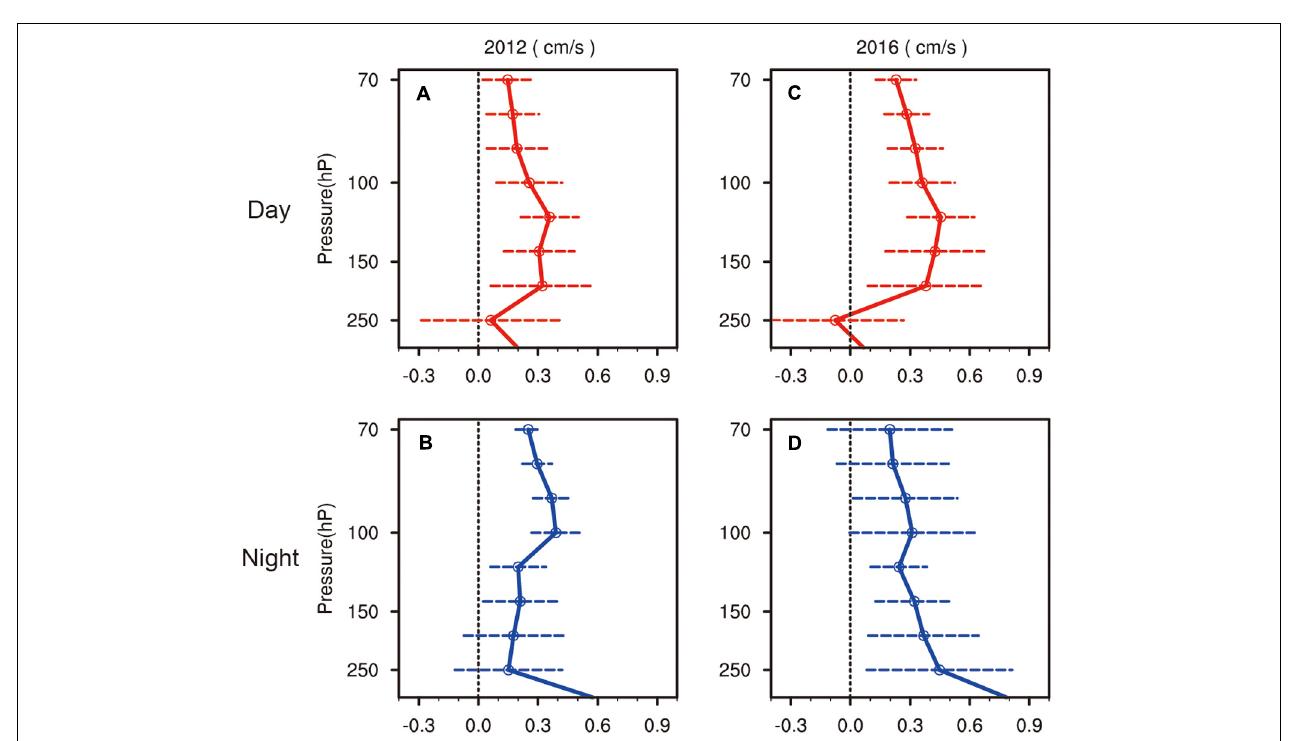
FIGURE 4 | Average deviation (solid lines) and standard error (dashed lines) between V AIRS and V ERA − I for 2012 (A,B) and 2016 (C,D) . The upper panels are daytime and the bottom panels nighttime.